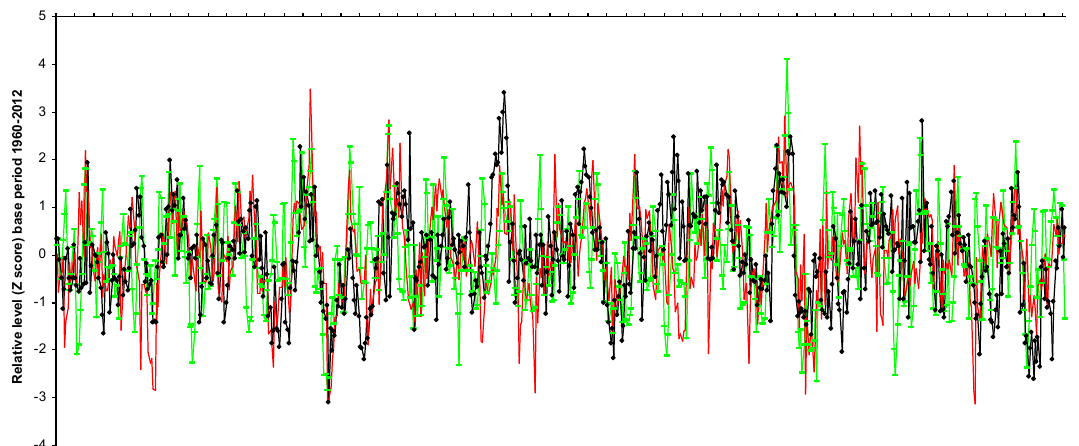
Figure 7. Z -scored monthly data from 1960-2012: sign-reversed SOI (unsmoothed and neither led nor lagged) (dotted black curve); second- difference CO 2 smoothed by 2 × 13 month moving average and led relative to SOI by 2 months (green dashed curve); and first-difference global surface temperature smoothed by a 13-month moving average and led by 3 months (red curve). Table 7. OLS dynamic regression between second-difference atmospheric CO 2 and reversed Southern Oscillation Index for monthly data for the period 1959–2012, with autocorrelation taken into account. Independent Dependent